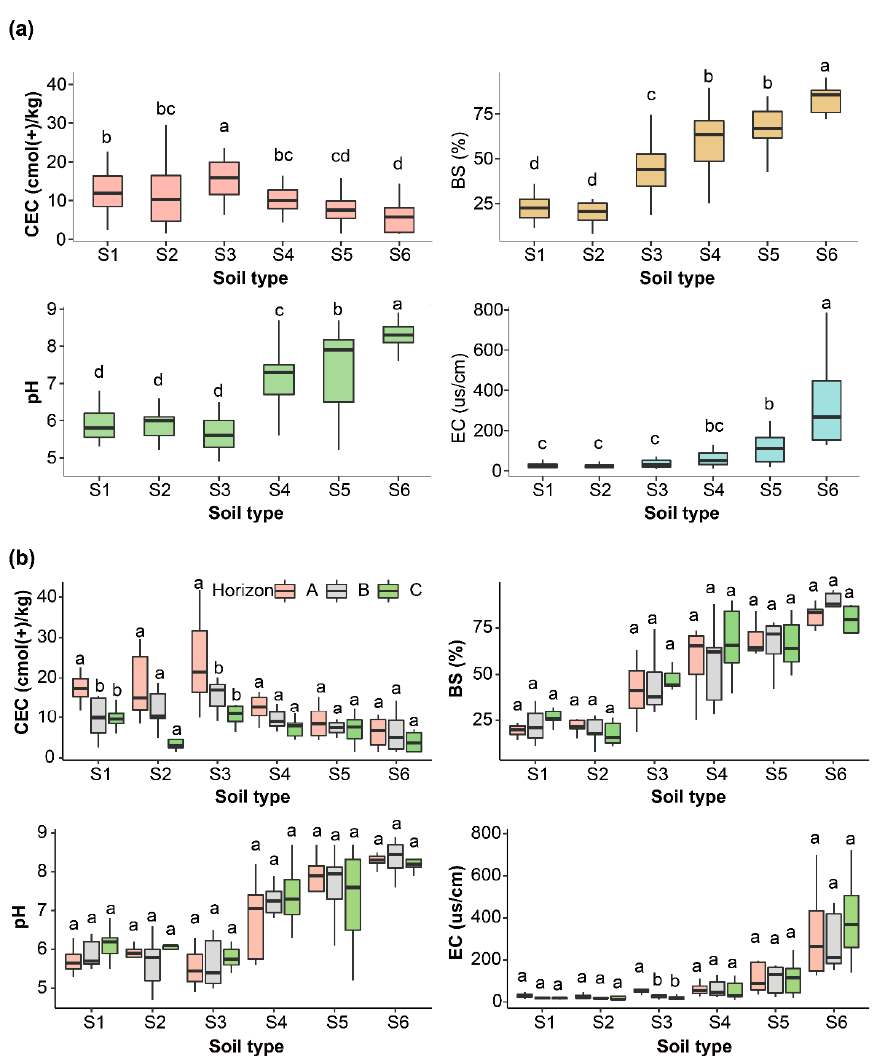
Figure 3. Variance analysis of soil cation exchange capacity (CEC), degree of base saturation (BS), pH value (pH), and electric conductivity (EC) in 6 soil types (subalpine meadow soil, S1; meadow soil, S2; dark brown soil, S3; brown soil, S4; yellow-brown soil, S5; and cinnamon soil, S6). The dif- ferent lowercase letters indicate significant differences in ( a ) at p < 0.05 by LSD test among 6 soil types, and the same letters indicate no significant differences at p < 0.05 by LSD test among 6 soil types. The different lowercase letters indicate significant differences in ( b ) at p < 0.05 by LSD test among 3 horizons (leaching horizon, A; sediment horizon, B; and parent material horizon, C) in the same soil types, and the same letters indicate no significant differences at p < 0.05 by LSD test among 3 horizons in the same soil types.